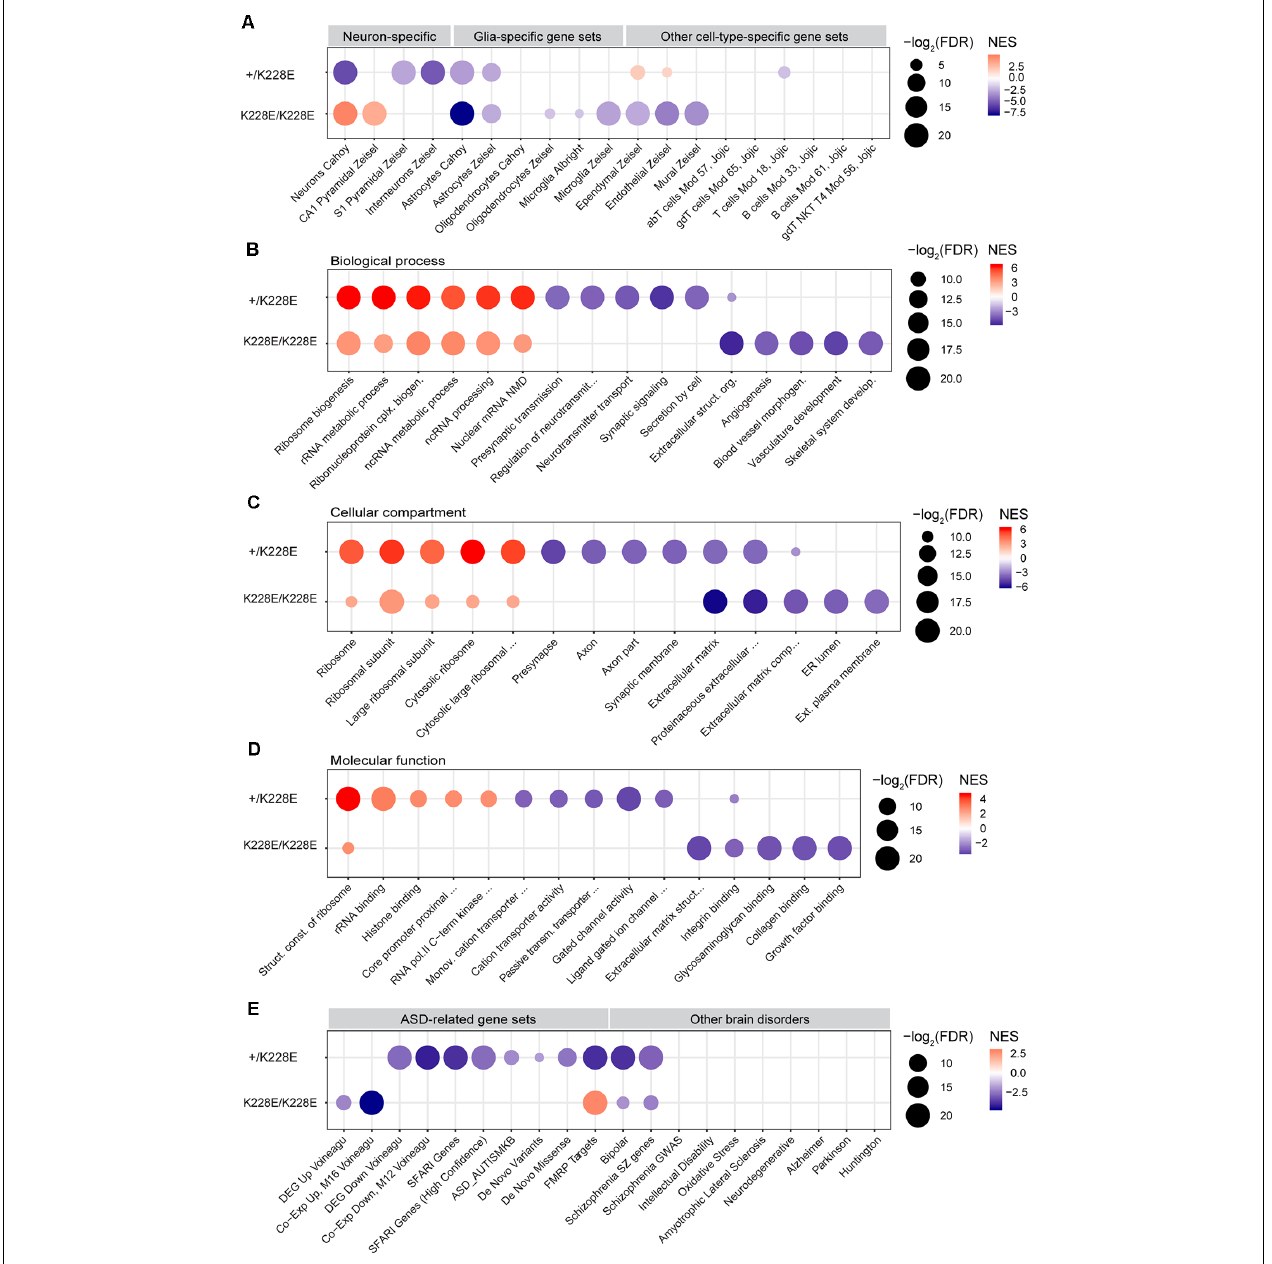
FIGURE 4 | Gene Set Enrichment Analysis (GSEA) of transcriptomes from Tbr1 + / K228E and Tbr1 K228E / K228E mice at E16.5. (A) Negative and dosage-dependent enrichment of Tbr1 + / K228E and Tbr1 K228E / K228E transcriptomes in the brain at E16.5 for astrocyte-related gene sets, but distinct enrichments of these lists for gene sets associated with neurons (pyramidal and interneuronal) and other cell types (ependymal, endothelial, and mural). Dot plots were drawn using normalized enrichment score (NES; color of circle) and false detection rate (FDR; intensity of circle) from GSEA results using a one-sided, weighted Smirnov–Kolmogorov test. FDR is the estimated probability that a gene set with a given NES represents a false-positive finding. n = 5 mice for WT, HT (heterozygous), and HM (homozygous), FDR < 0.05 (see Supplementary Table S1 for details). (B–D) Positive and inverse dosage-dependence of Tbr1 + / K228E and Tbr1 K228E / K228E transcriptomes (E16.5) for ribosome-related gene sets, but negative and distinct enrichment of the Tbr1 + / K228E transcriptome for synapse-related gene sets and the Tbr1 K228E / K228E transcriptome for ECM-related gene sets. GSEA was performed using precurated GO gene sets in Biological Function (B) , Cellular Component (C) , and Molecular Function (D) domains in the C5 category. The top 4–6 gene sets in each GO domain are indicated. n = 5 mice for WT, HT (heterozygous), and HM (homozygous), FDR < 0.05 (see Supplementary Table S1 for details). (E) Negative enrichment of the Tbr1 + / K228E transcriptome for ASD-related gene sets, but no or opposite enrichment of the Tbr1 K228E / K228E transcriptome for ASD-related gene sets. Note that the Tbr1 + / K228E transcriptome, but not the Tbr1 K228E / K228E transcriptome, also shows enrichment for bipolar disease- and schizophrenia-related gene sets. n = 5 mice for WT, HT (heterozygous), and HM (homozygous), FDR < 0.05 (see Supplementary Table S1 for details).